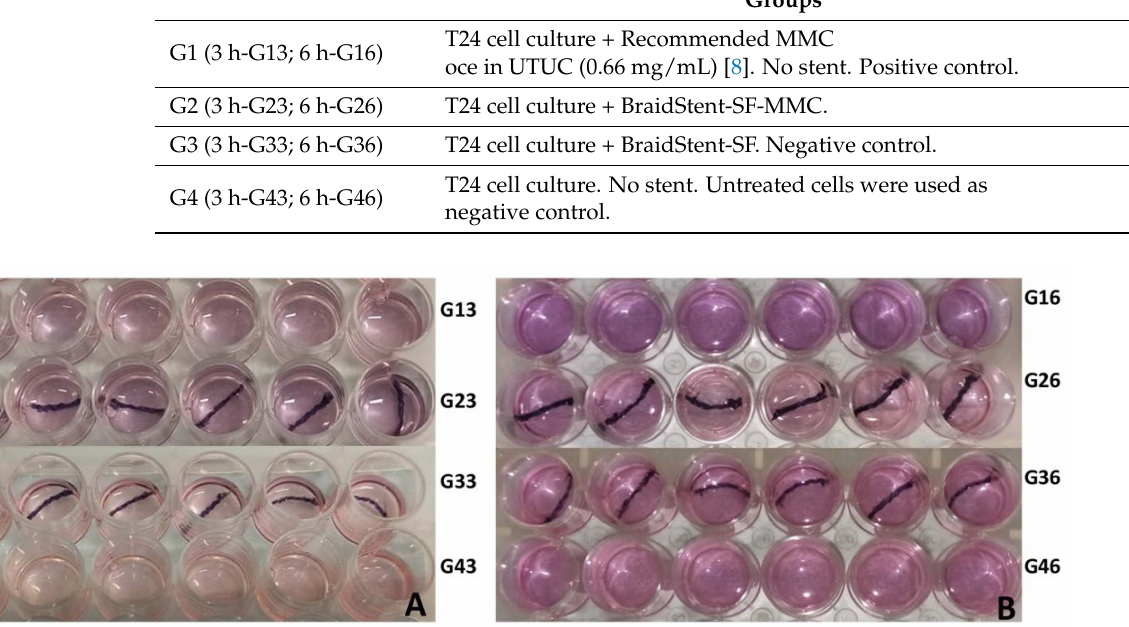
Figure 1. The figure shows the plates that constitute the experimental trial. Each row corresponds to an experimental group. ( A ) refers to T3 (3 h), and ( B ) refers to follow-up at T6 (6